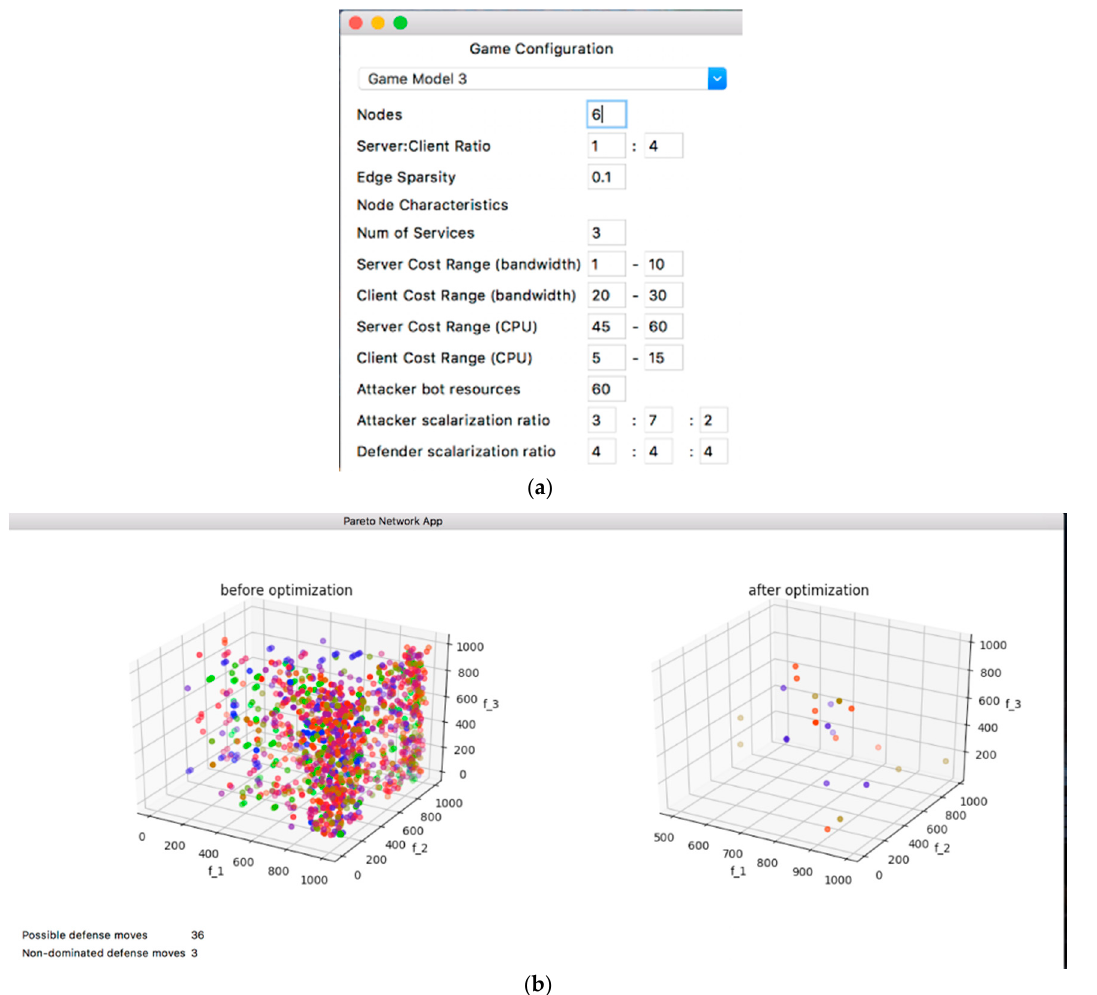
Figure 11. PDSSS system overview. ( a ) Control panel; ( b ) Results display. Table 6. Configuration for a simple network.